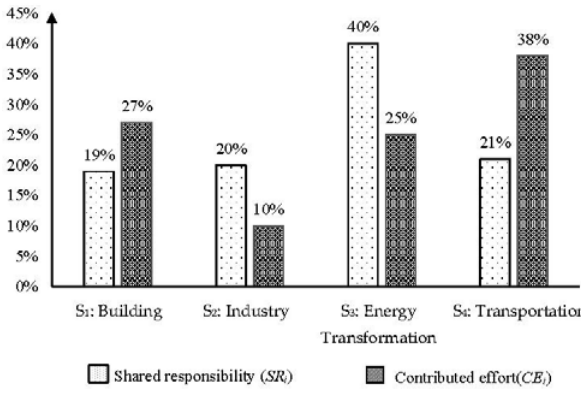
Figure 7. Gaps between shared responsibility and contributed effort.